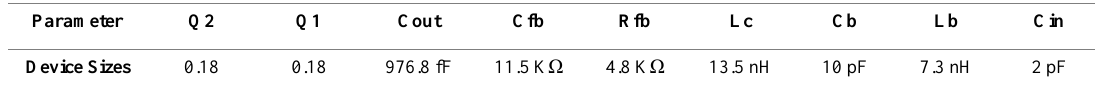
Figure 2. Schematic of the L-band LNA. Table 1. Device sizes for the L-band CMOS